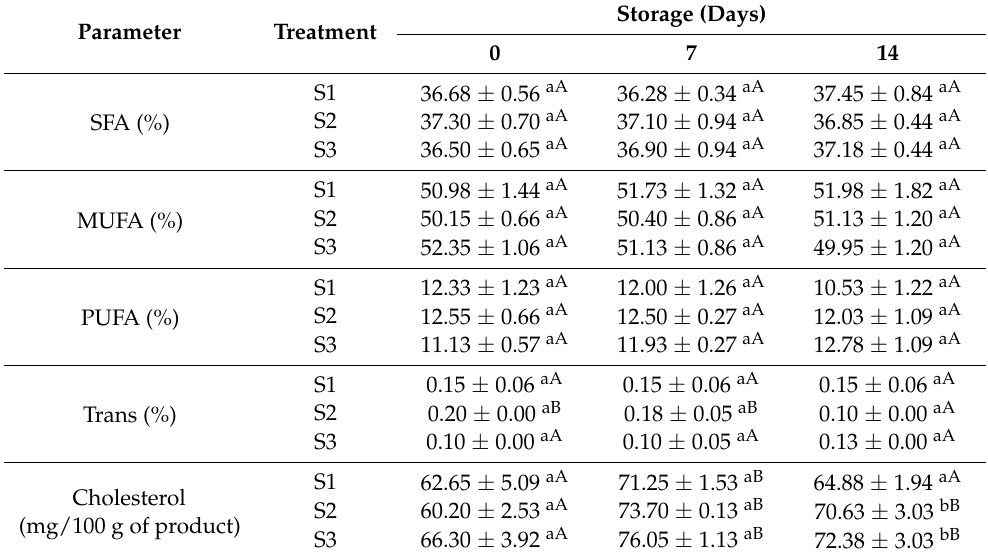
Table 2. Fatty acid composition and cholesterol content in the examined pork hams. Parameter Treatment